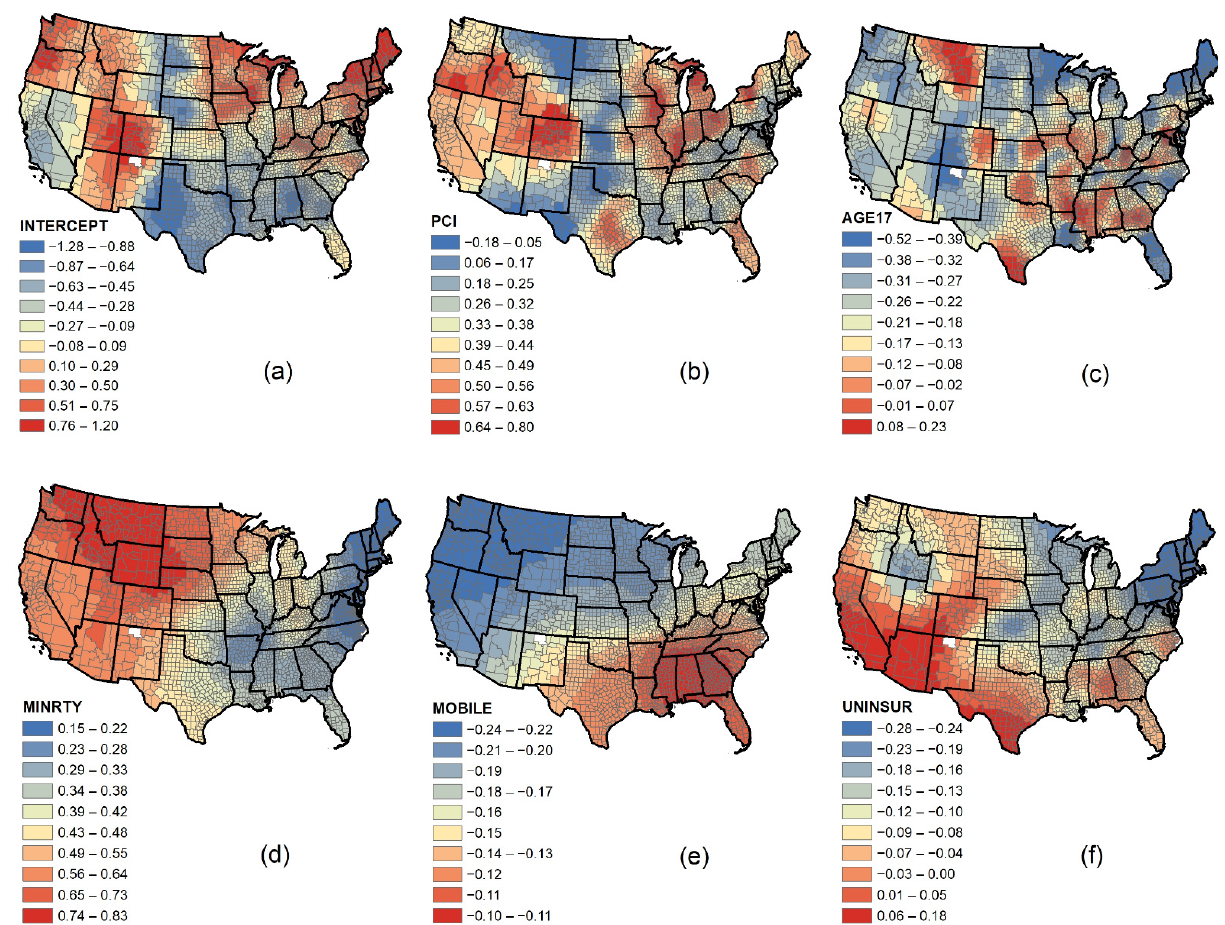
Figure 3. The effects of ( a ) Intercept; ( b ) Per capita income; ( c ) Age 17 and younger (%); ( d ) Minority (%); ( e ) Mobile homes (%), and ( f ) Uninsured people (%) on COVID-19 vaccination rate (as of 29 July 2021) in the United States, obtained from MGWR model.